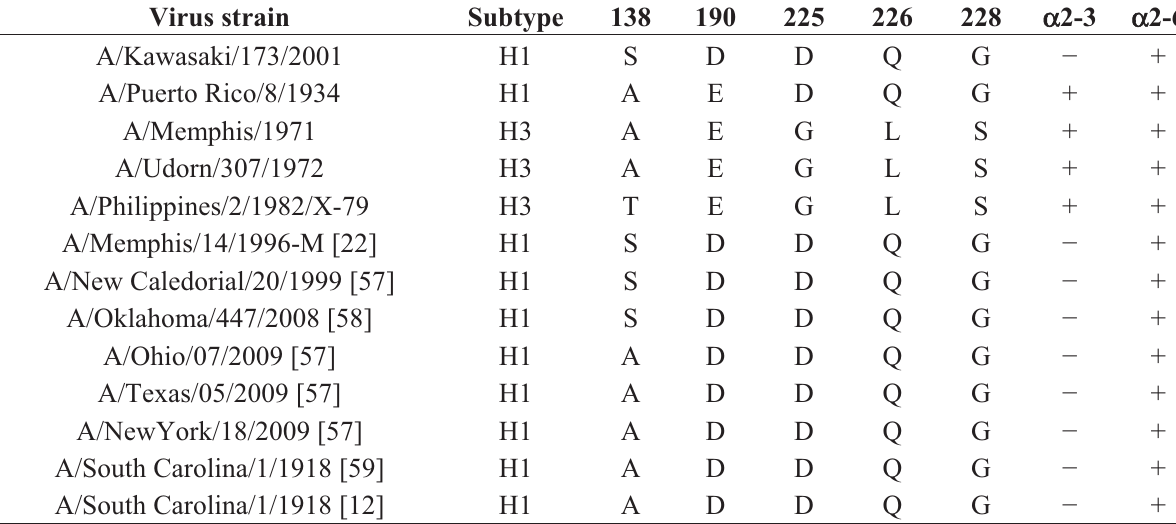
Table 4. Five amino acid residues at the receptor binding site (RBS) of HA glycoproteins for 38 human H1 strains and 23 human H3 strains and their respective receptor